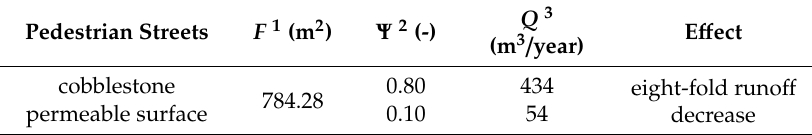
Table 7. Data summary for parking spaces of impermeable and permeable